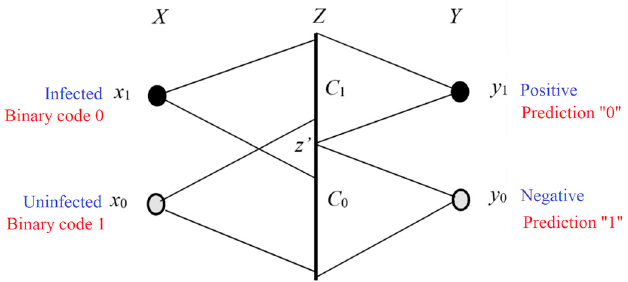
Figure 6. Illustrating the medical test and signal detection. We choose y j according to z ∈ C j . { C 0 , C 1 } is a partition of C .